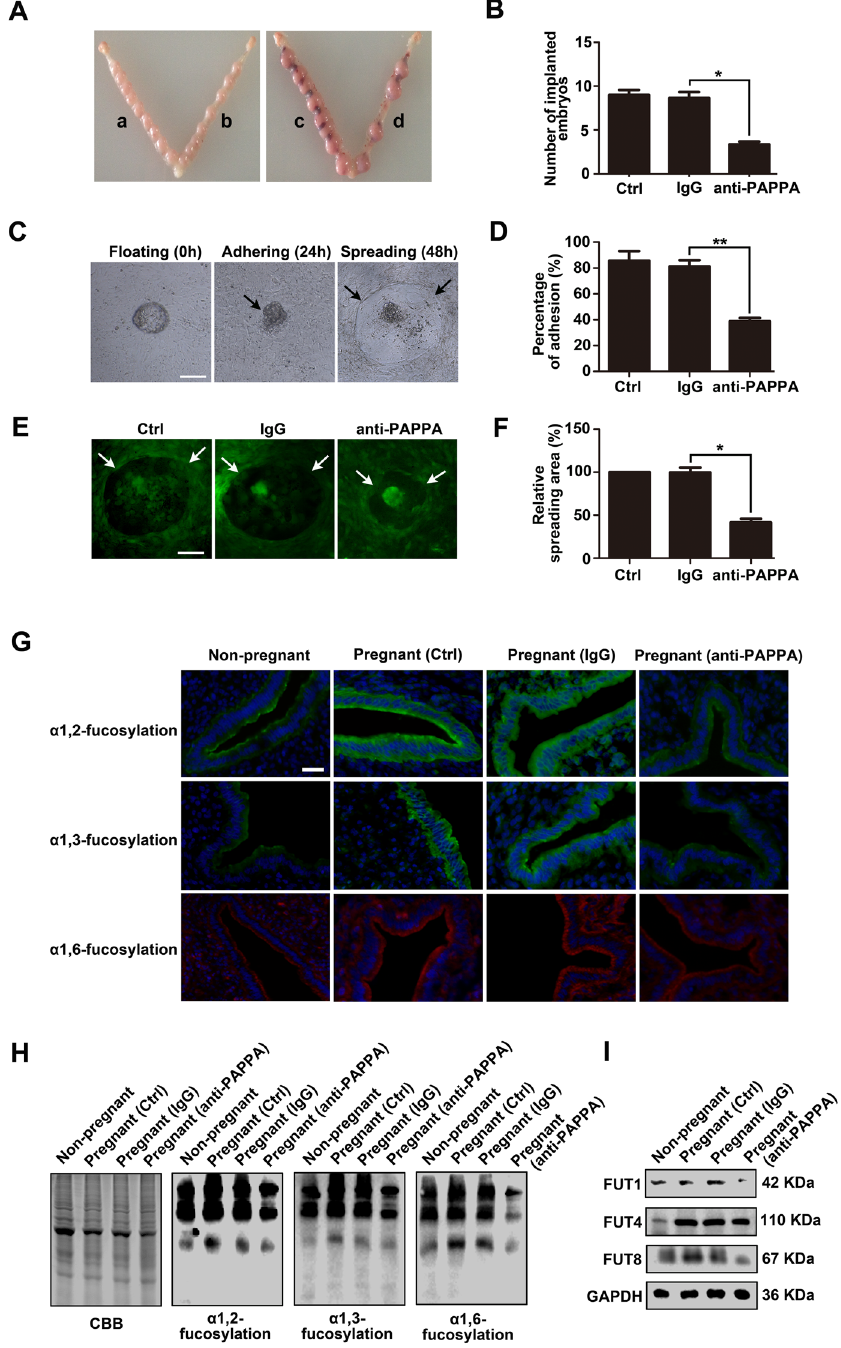
Figure 7. PAPPA blockade inhibits embryo implantation in vivo , mouse embryo adhesion and spreading in vitro , as well as the specific N-fucosylation of pregnant mouse endometrium. Mouse uterine horns were injected with IgG or anti-PAPPA at pregnant day 3 (PD3). Mice were ethically scarified at PD8, and ( A ) the implanted embryos were photographed (a, IgG; b, no treatment; c, IgG; d, anti-PAPPA). ( B ) The number of implanted embryos was analyzed and is shown in the histogram. Mouse embryos were collected at PD4. Embryos were co-cultured with mouse primary endometrial cells. ( C ) The same embryo was photographed at 0 h, 24 h and 48 h, representing the floating, adhering and spreading status, respectively. IgG or anti-PAPPA was added to the co-culturing medium. ( D ) The adhesion rate was analyzed and shown in the histogram after co-culturing for 24 h. ( E ) 48 h later, endometrial cells and embryos were stained with CMFDA and were photographed. ( F ) The histogram showed the relative spreading area. Total proteins or tissues of the endometrium were harvested at PD4. ( G ) Lectin flourescent staining and ( H ) Lectin blotting detected the specific N-fucosylation of endometrium ( I ) Western blotting showed the expression of FUT1, FUT4 and FUT8. GAPDH was used as an internal control. The bars represent 100 μ m. * p < 0.05, ** p < 0.01. The data were presented as the means ± SEM of three independent